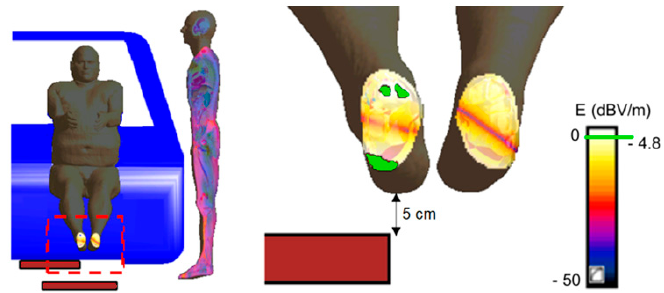
Figure 6. Induced electric field inside Duke and Fats for the misaligned coil position. E-field normalized to the peak value of 19.9 V/m. BR = 11.48 V/m ≈ − 4.8 dBV/m (green area is the portion where the BR is exceeded). Table 5. Comparison of the peak induced electric field averaged over a 2 × 2 × 2 mm 3 cube and the BR for the considered exposure scenarios Standing & Driving